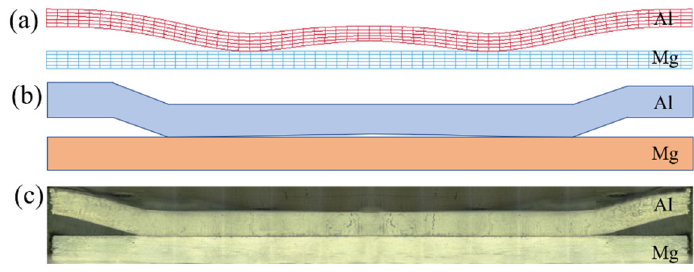
Figure 17. Comparison diagram of Al-Mg magnetic pulse welding joint interface. ( a ) Simulation diagram; ( b ) ideal schematic; ( c ) actual welding